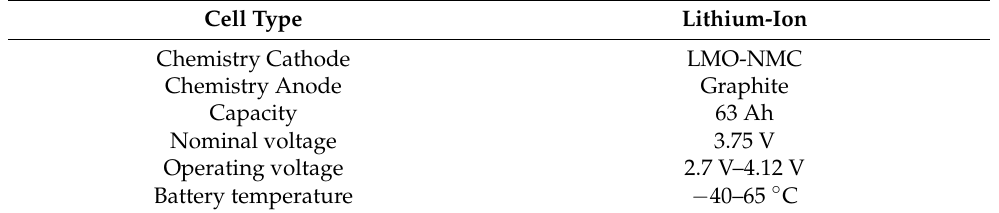
Table 2. Lithium-ion battery technical specifications from the